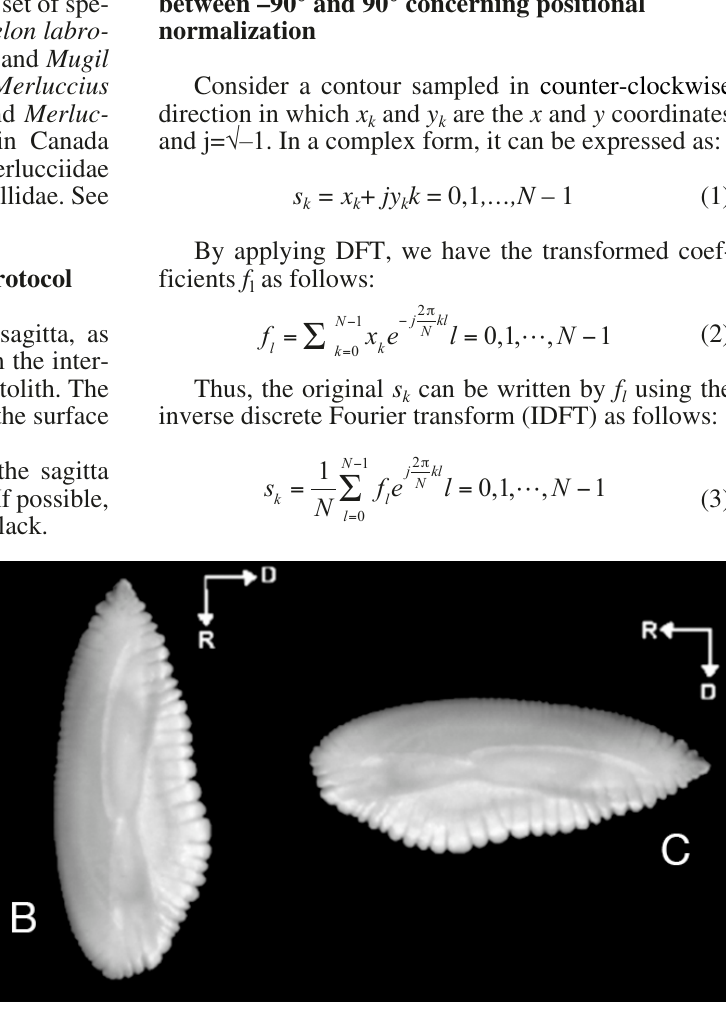
Fig. 3. – Concerning the positional normalization of left sagitta, the otolith dorsal side (D) must be placed in the dorsal position of the image and the anterior or rostral side (R) on the right side. A, right position; B, wrong position 1; C, wrong position